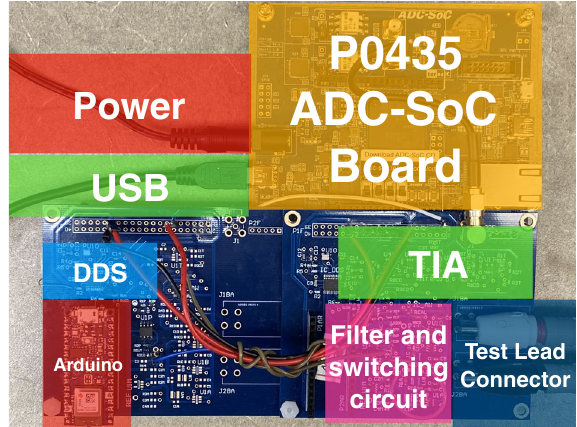
Figure 3. The proposed FDICS.